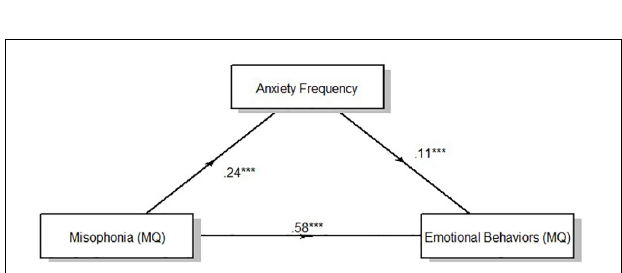
FIGURE 3 | Overall mediation model for anxiety frequency. Standardized path coefficients. *** p < 0.001, all two tailed.